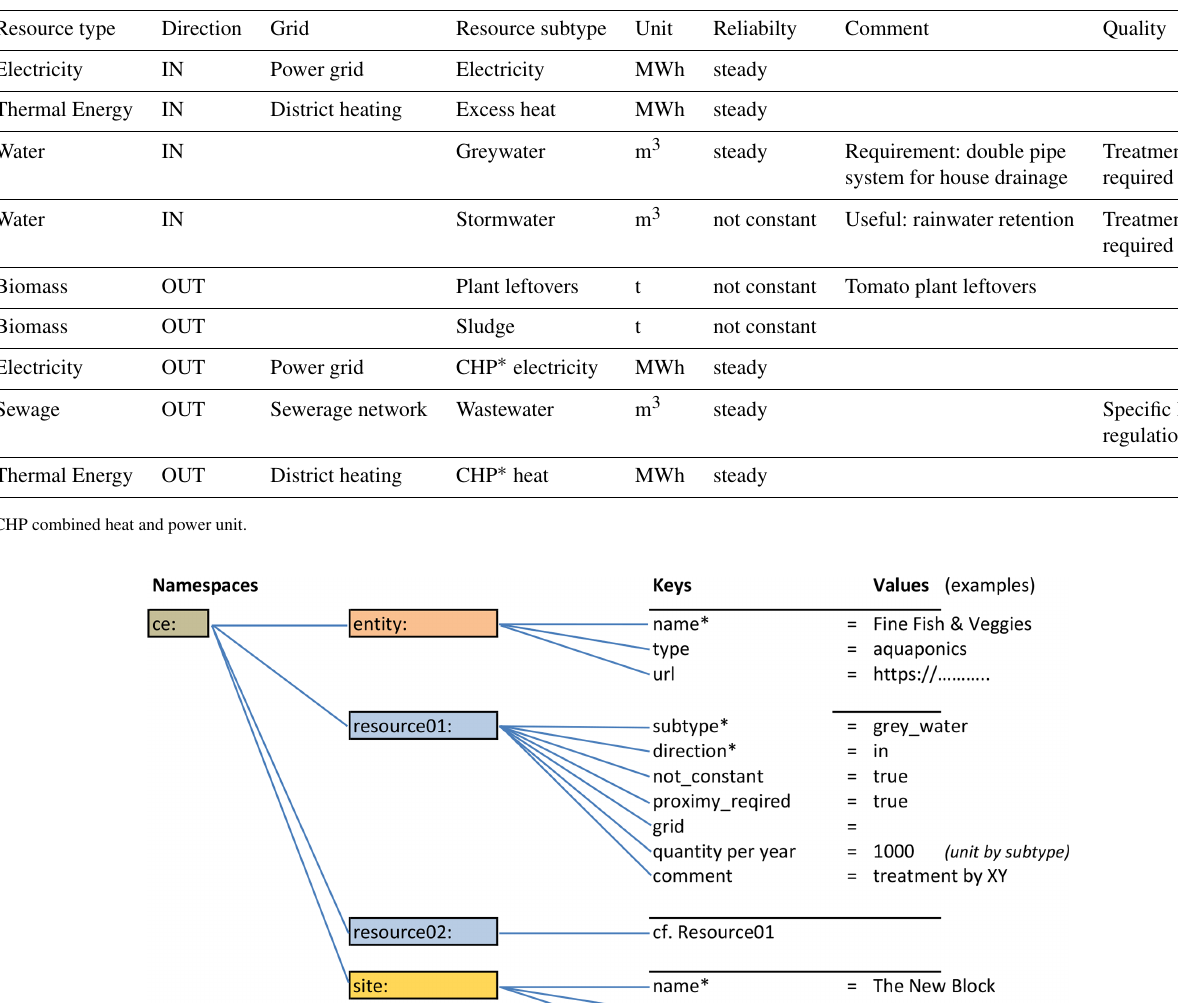
Table 2. Resource catalogue excerpt – example records for aquaponics as a CE entity.